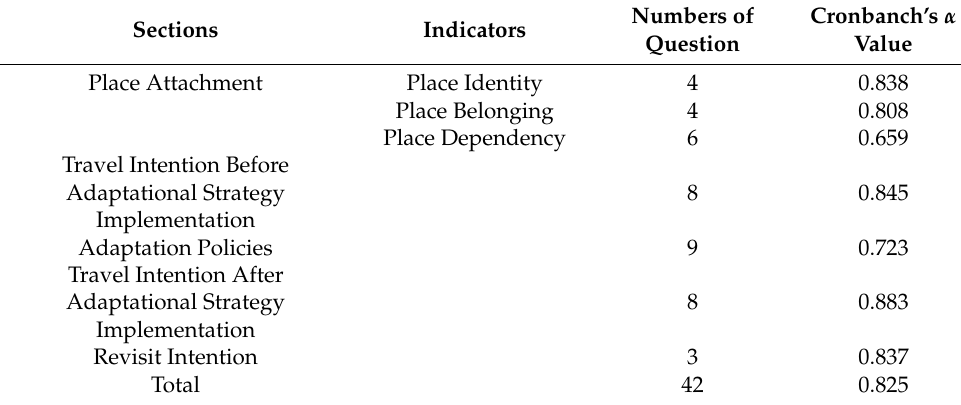
Table 3. Reliability analysis results.